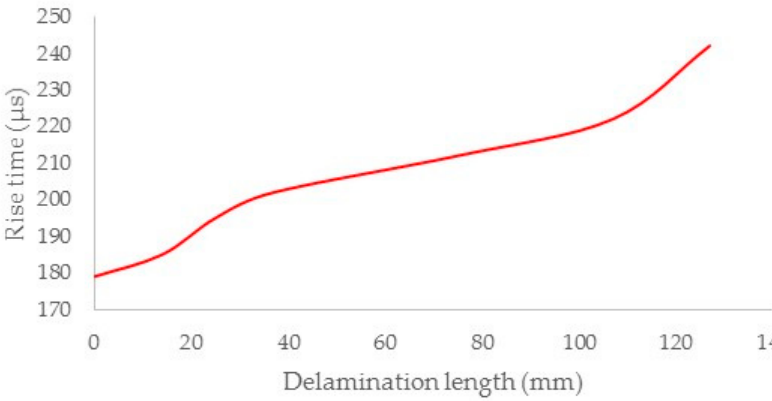
Figure 20. Evolution of average rise time versus the delamination length in the [0°/30°] 2s laminates.